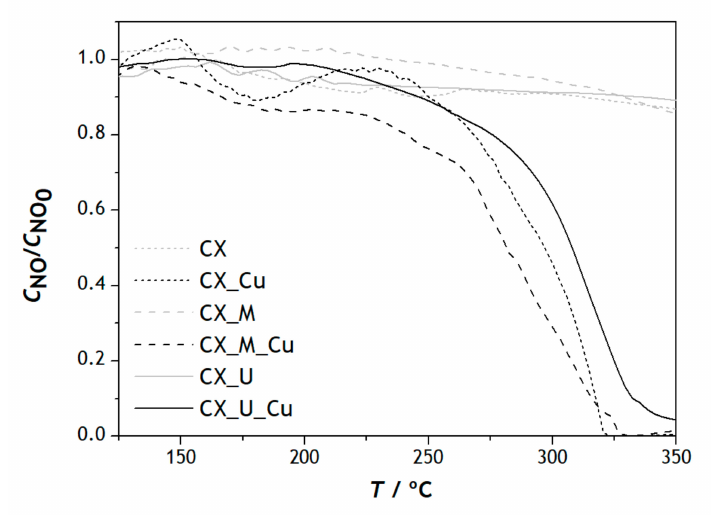
Figure 4. NO concentration in the presence of CX and CX_N with and without metals with [NO] = 1000 ppm in He with 5% of O 2 .